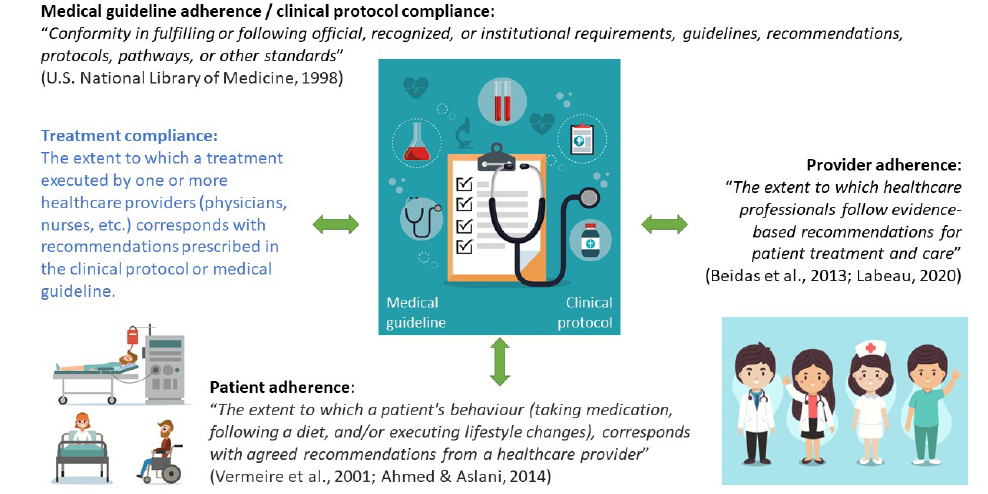
Figure 1. Compliance in the medical domain defined, showing the general definition by the U.S. National Library of Medicine [34] and the different perspectives of patient adherence [31,32] and provider adherence [17,33], including the perspective of treatment compliance, as proposed in this paper. (Images by